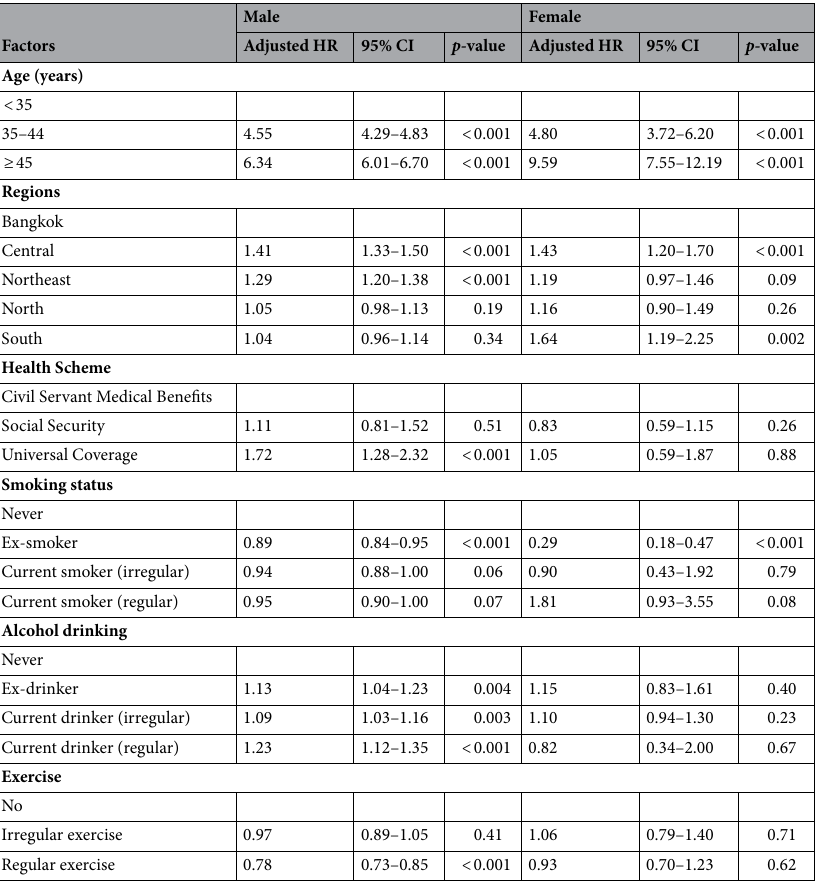
Table 4. Multivariable analysis of the association between demographic, behavioral, and clinical factors and the incidence of metabolic syndrome among RTA personnel, stratified by sex. HR hazard ratio, 95% CI 95% confidence